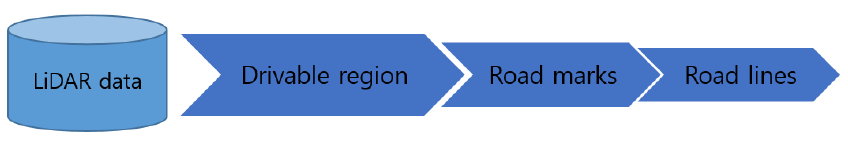
Figure 1. LiDAR point